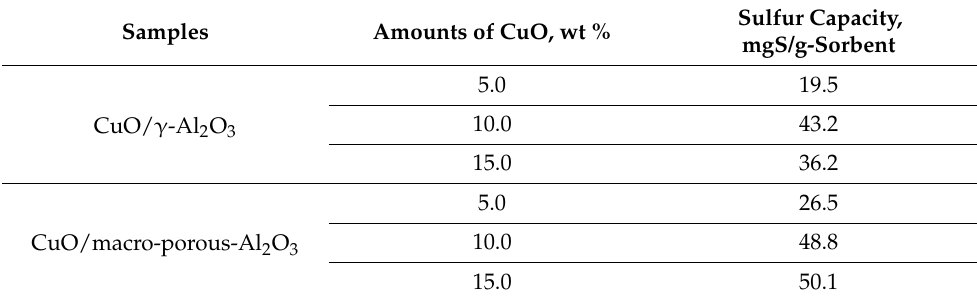
Table 2. Sulfur capacity of the Cu-based desulfurization sorbents according to the CuO